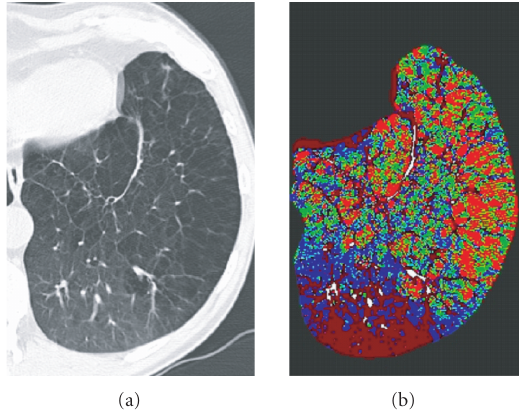
Figure 4: Morphological CT (a) and perfusion map of an emphy- sematous lung show good correlation of severe emphysema in the anterior-lateral parts of the lung and decreased perfusion (green pixels) as compared to the normal posterior parts of the lung. The bright red pixels represent excluded, air containing parts of the lung.